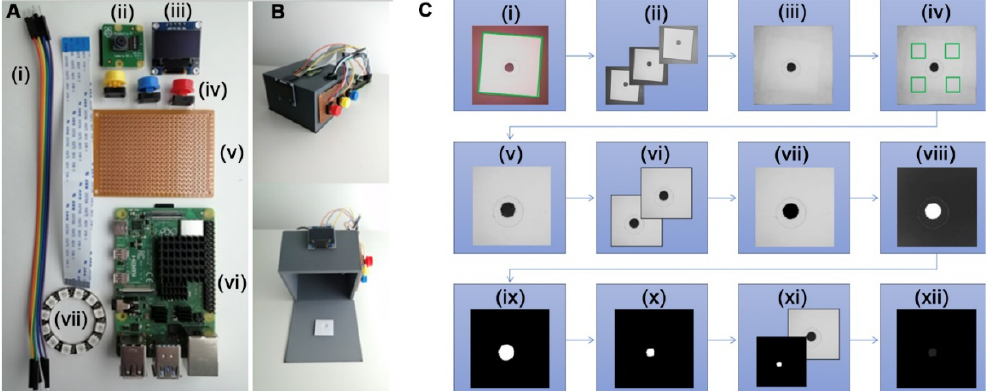
Figure 1. Reader hardware and software for automated quantification of colorimetric signals in paper-based immunosensors: ( A ) Reader components, ( i ) connecting cables, ( ii ) image sensor, ( iii ) display screen, ( iv ) push buttons, ( v ) solder board, ( vi ) single board computer, ( vii ) LED ring; ( B ) Photographs of the reader mounted on an 8 × 8 × 5 cm 3D-printed box with a detached bottom panel; ( C ) Image capture and post-processing algorithmic workflow: ( i ) image capture upon edge detection, ( ii ) split RGB channels, ( iii ) crop outer edge of G channel image, ( iv ) measure background, ( v ) center crop and resize, ( vi ) duplicate, ( vii ) threshold, ( viii ) invert, ( ix ) binarize for mask, ( x ) dilate and erode mask, ( xi ) apply mask to duplicate, ( xii ) measure ROI.